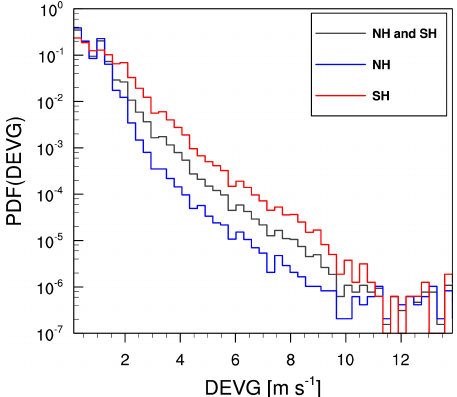
Figure 7. The PDFs of the QCDEVG over the globe (NH and SH: black line), NH (blue line), and SH (red line) at altitudes above 15kft ( ∼ 4 . 57km) from October 2015 to September